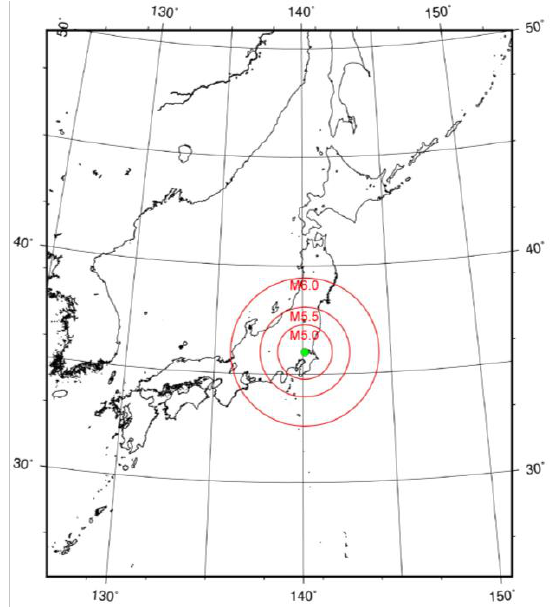
Figure 1. The radius (km) calculated according to the Dobrovolsky radius condition with magnitudes (Ms) = 5.0, 5.5 and 6.0. The red circles represent the maximum range for earthquakes of each M. The solid green circle represents the location of the farm used to observe milk